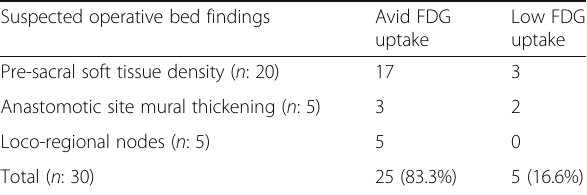
Table 3 Distribution of the studied patients according to the degree of FDG uptake by the suspicious rectal operative bed